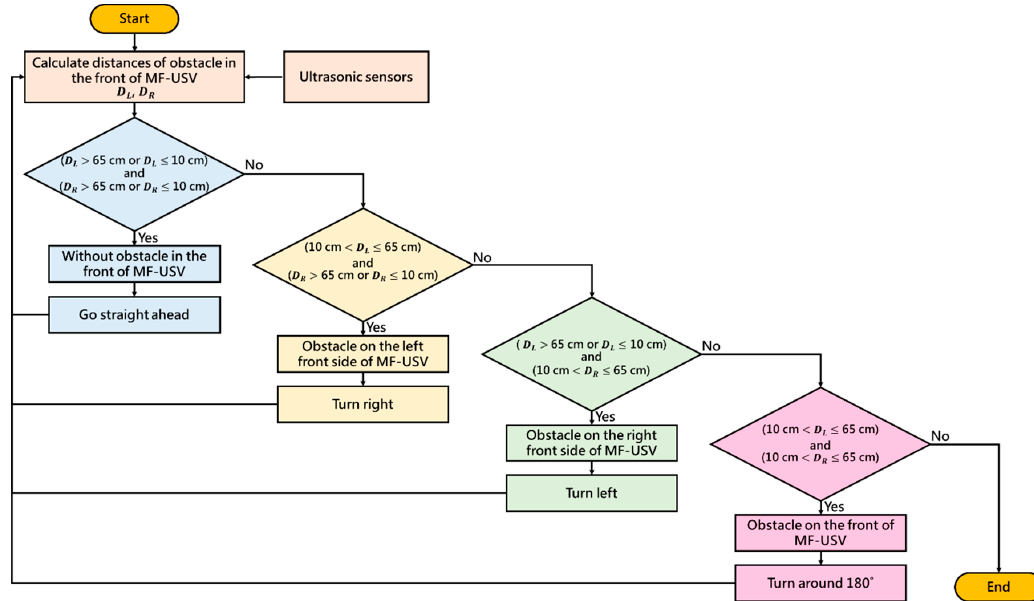
Figure 5. Threshold-based obstacle avoidance algorithm.